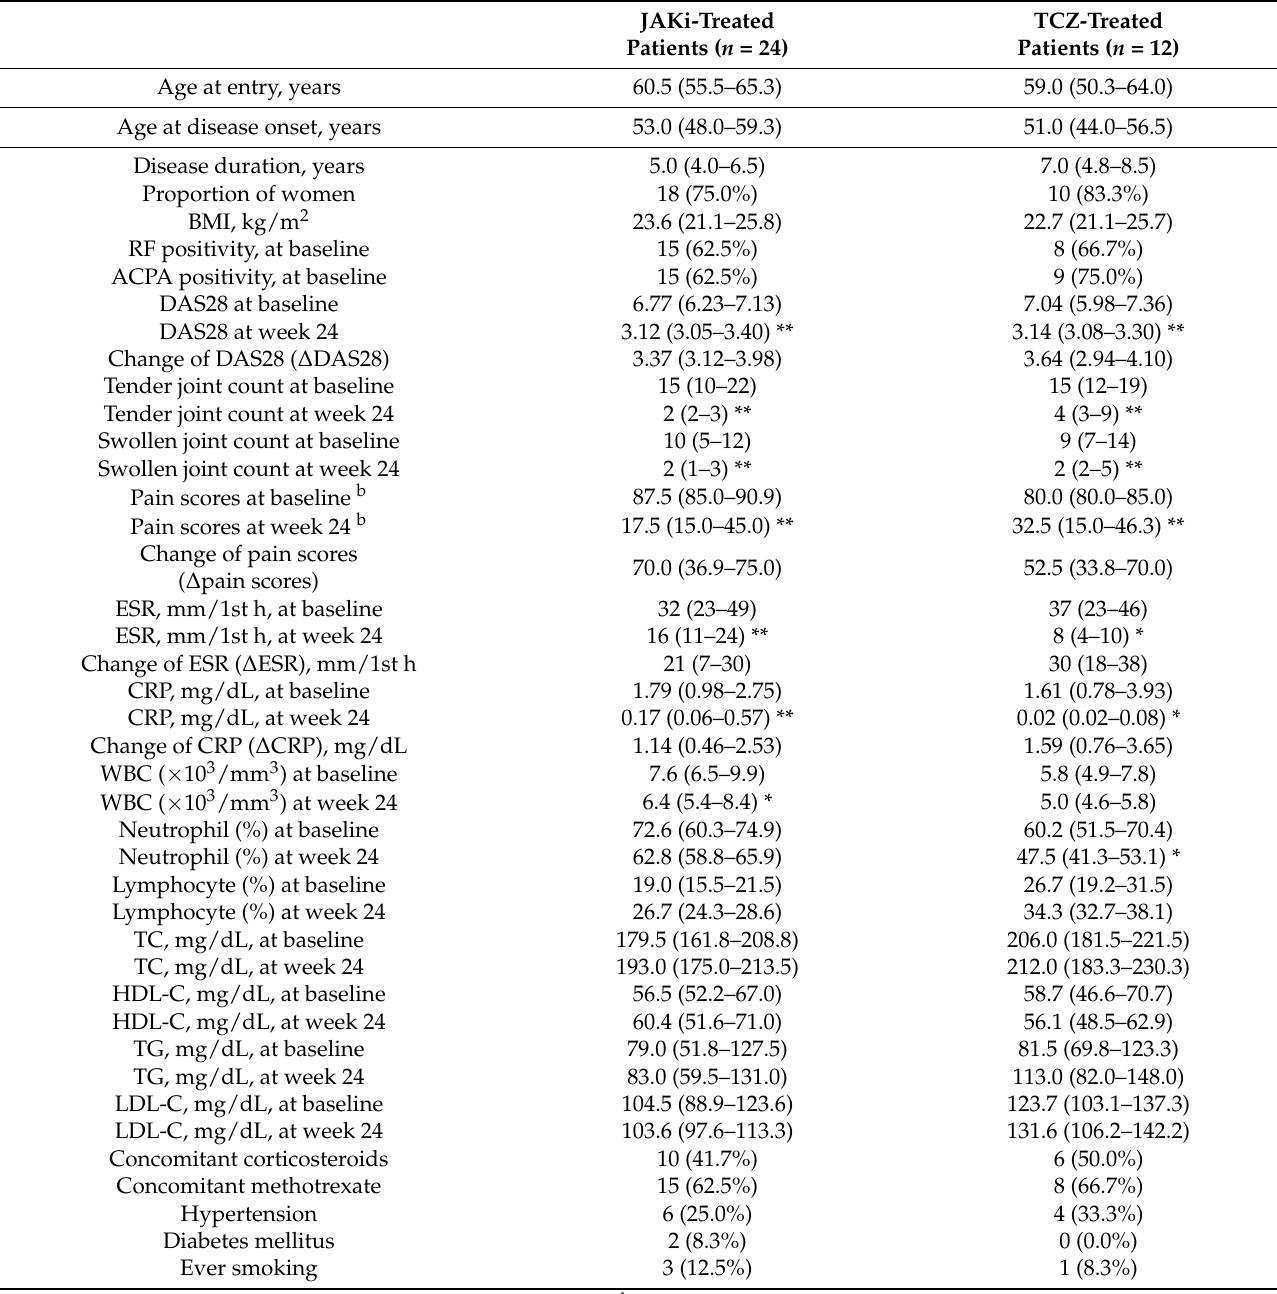
Table 1. Demographic, clinical characteristics, and laboratory data in rheumatoid arthritis (RA) patients treated with Janus kinase inhibitors (JAKi) or tocilizumab (TCZ) a